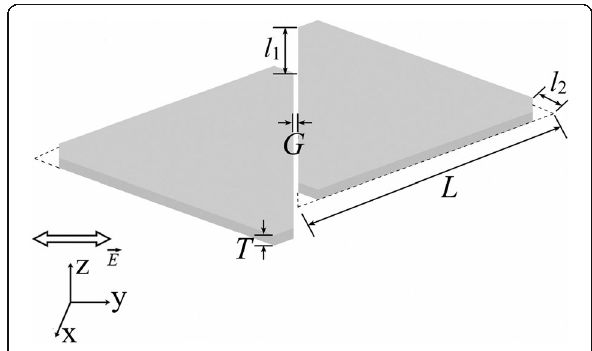
Fig. 1 Schematic diagram of the Ag TNP dimer showing a